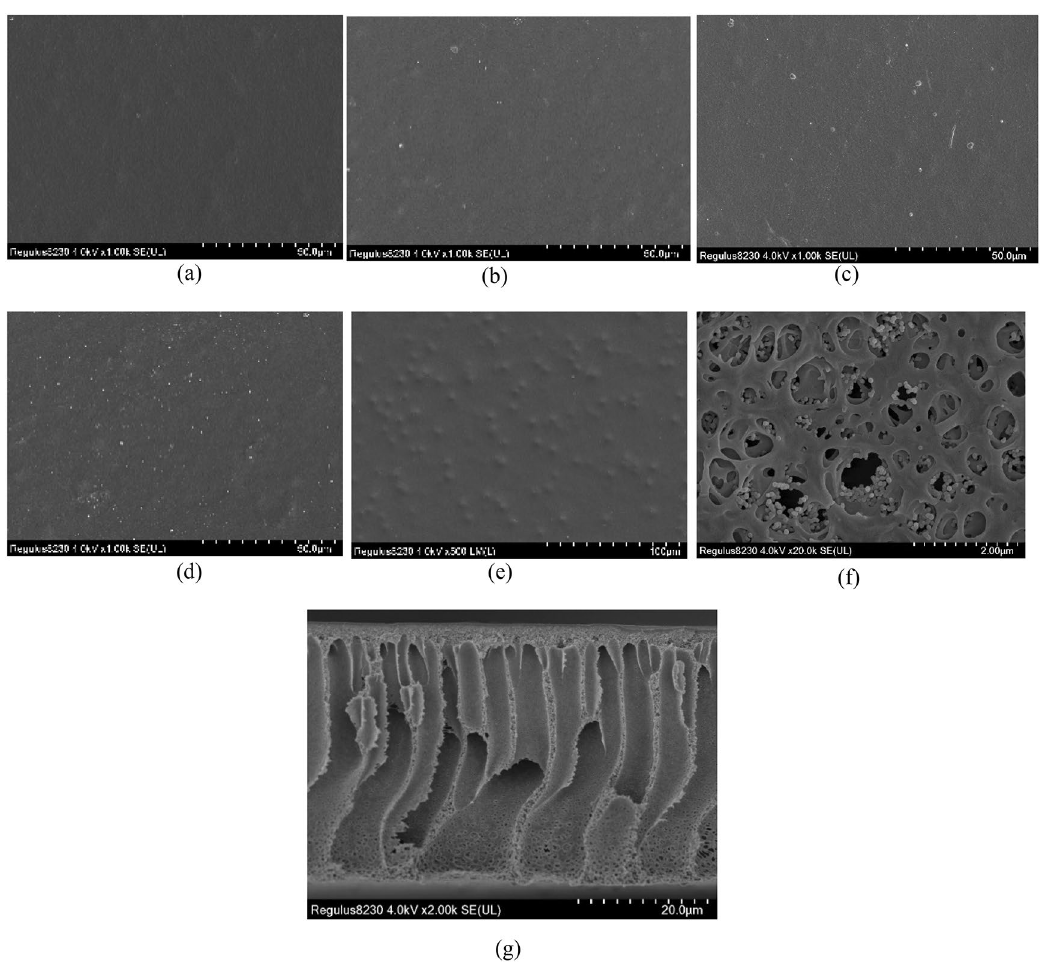
Figure 2. SEM images of composite membranes. ( a – e ) Front images of composite membranes, fumed silica contents are ( a ) 0.0 wt%, ( b ) 0.2 wt%, ( c ) 0.4 wt%, ( d ) 0.6 wt%, and ( e ) 0.8 wt%. ( f ): Reverse side image of PES/ PEBA 0.6 . ( g ): Cross-section image of PES/PEBA 0.6